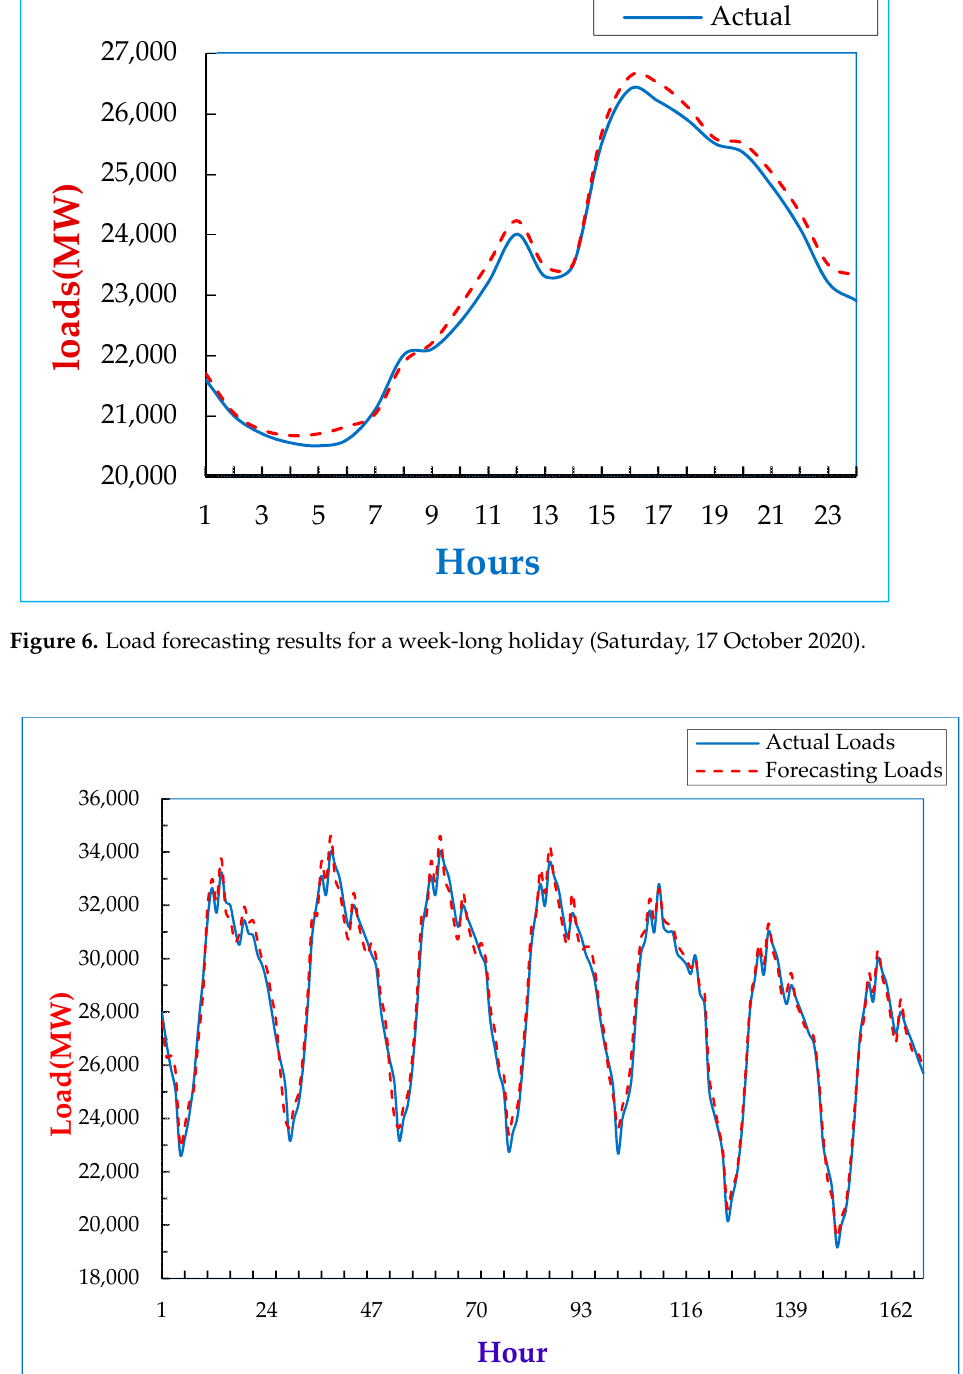
Figure 5. Load forecasting results for working days (Wednesday, 16 September 2020).